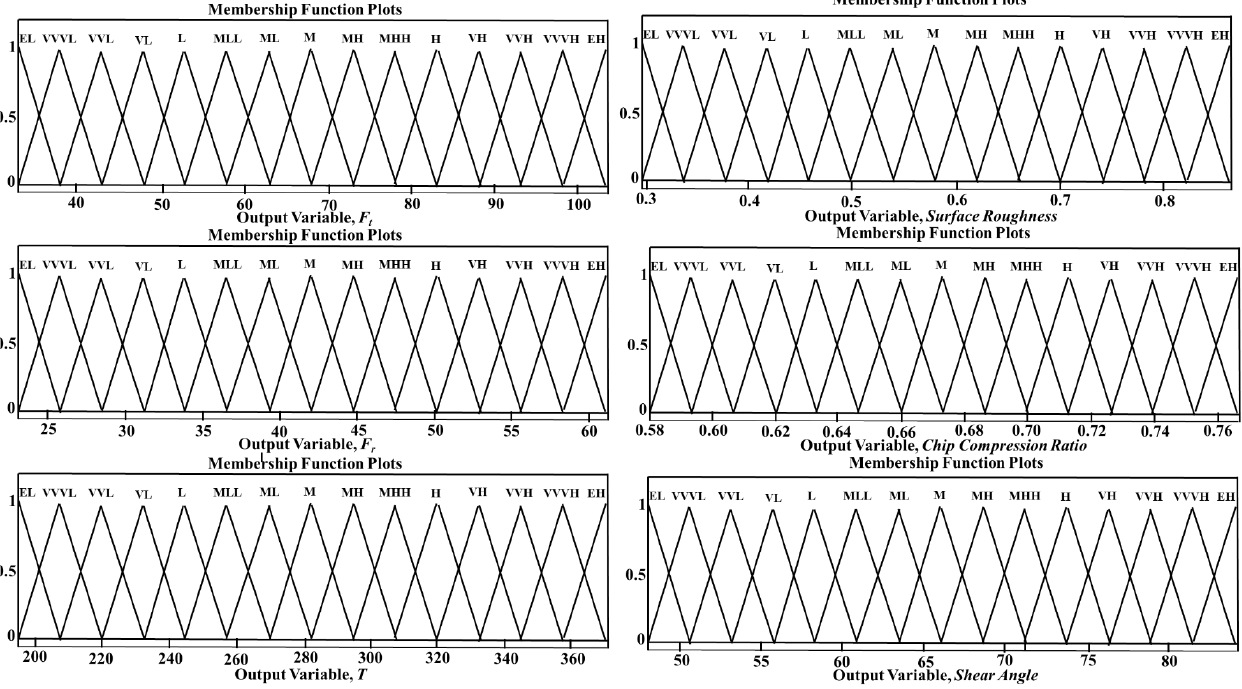
Figure 4. Output variables with associated membership functions used in the simulation of CT.